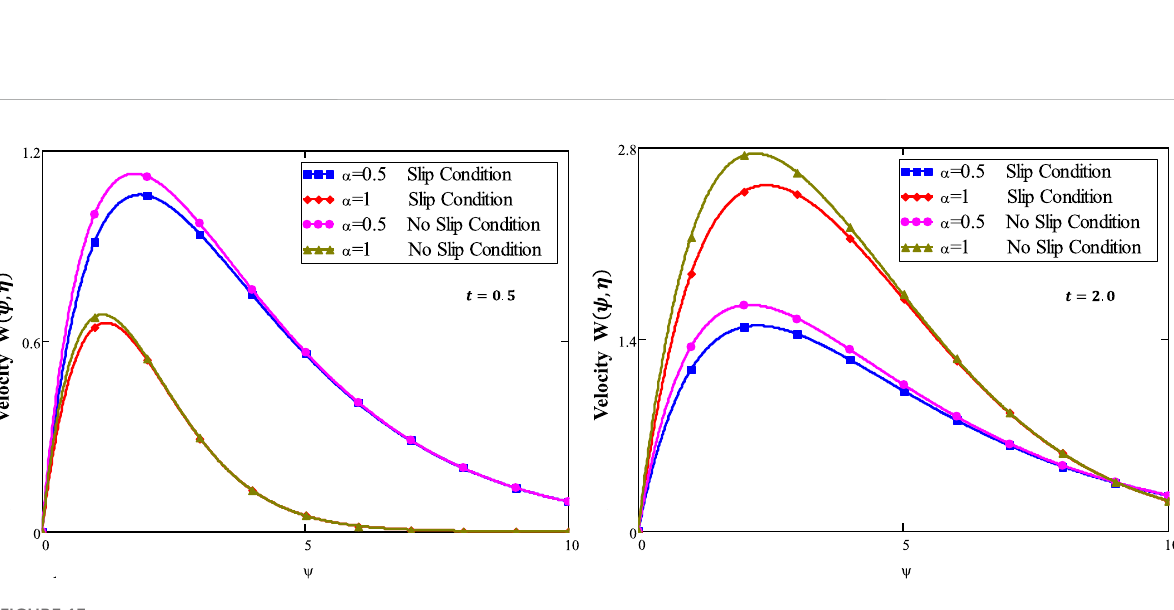
FIGURE 13 Simulation to clarify the velocity for the slip and no-slip condition when Pr (cid:3) 6 . 2 , ϕ 1 (cid:3) ϕ 2 (cid:3) 0 . 2 , Gr (cid:3) 8 , Gm (cid:3) 4 . 5 , Sc (cid:3) 0 . 5 , λ 1 (cid:3) 0 . 7 , and λ 1 (cid:3) 0 .